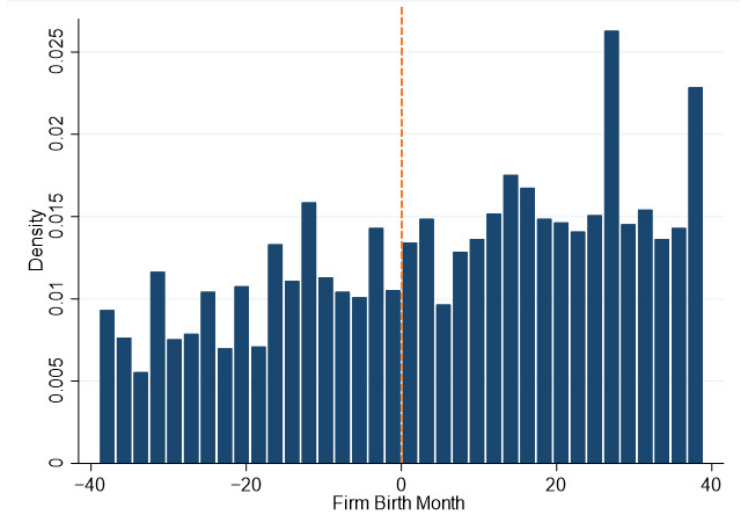
Figure 7. Identification checks: Number of entrants by month of entry around the reform.